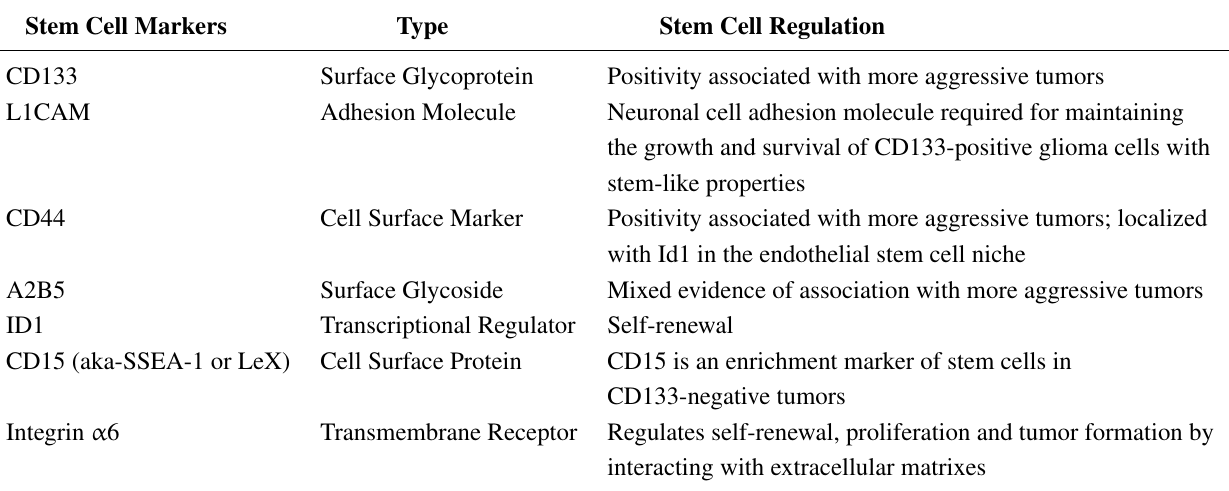
Table 1. Stem cell markers in